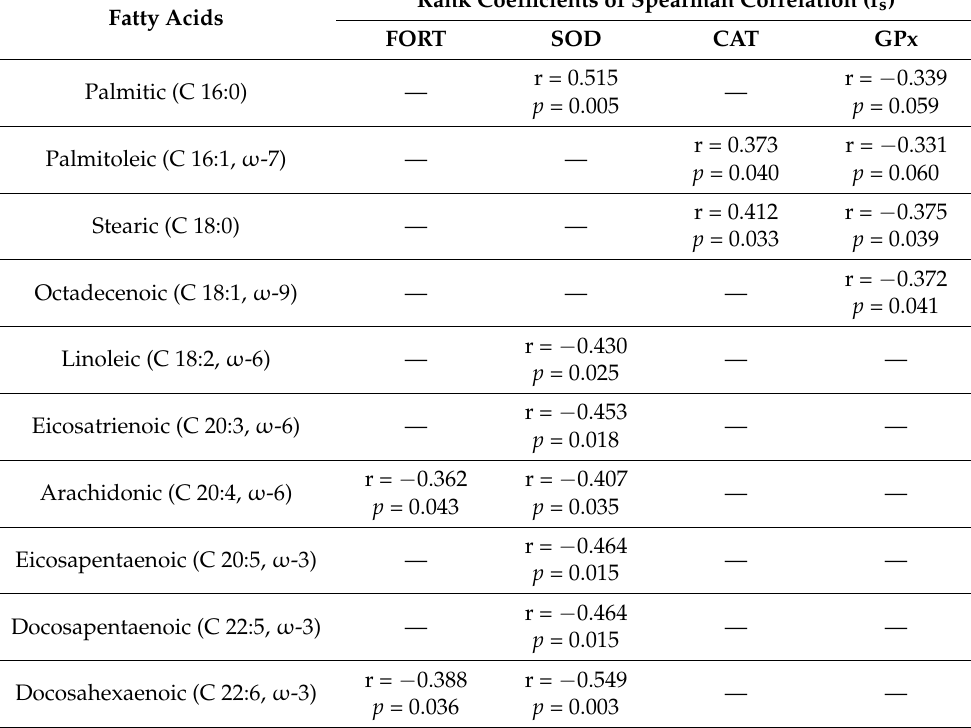
Table 4. The associations between the content of FAs and the antioxidant system enzymes in men with ischemic artery disease and the presence of vulnerable atherosclerotic plaques in the coronary arteries (Subgroup A).